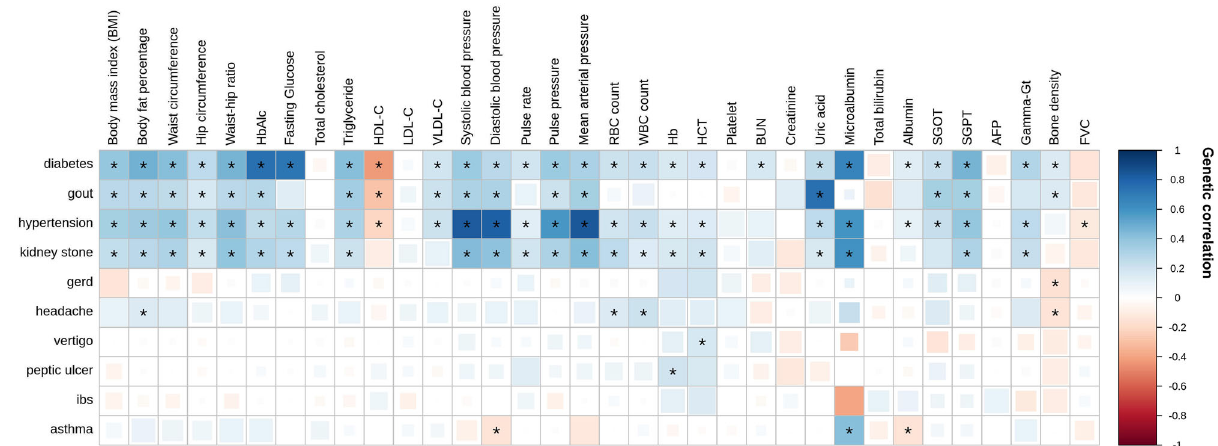
Fig. 2 Genetic correlation between binary and quantitative traits. Pairwise genetic correlations ( n = 946) were estimated by bivariate LD score regression (full correlation results are shown in Supplementary Fig. 2). Only correlations between 10 binary traits and 34 quantitative traits ( n = 340) are presented in this fi gure. Positive and negative correlations are colored in blue and red, respectively. The intensity of correlation is indicated by the color saturation. The FDR is calculated by the Benjamini – Hochberg method. Size of the color block represents the FDR of each correlation, and signi fi cant correlations (FDR ≤ 0.05) are indicated by asterisks.